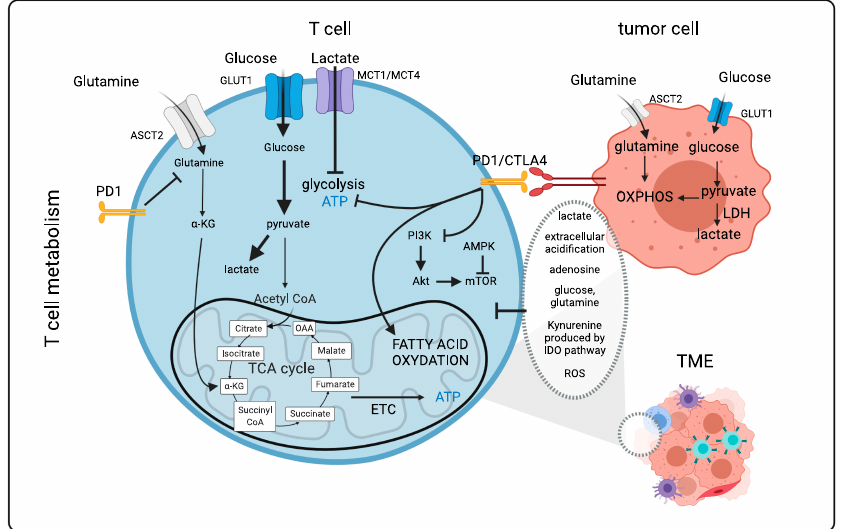
Figure 1 . T cell metabolism in the tumor microenvironment . Naïve T cells rely mainly on oxidative metabolism. Following activation with an antigen, T cells switch to a glycolytic metabolism by activation of the mTOR pathway. This metabolic program supports effector T cell functions. If antigen stimulation persists long term, such as in the tumor environment, inhibitory receptors such as PD1 and CTLA4 can rewire T cell metabolism by reducing glycolysis and glutaminolysis, which weakens effector functions. Other factors in the TME contributing to the exhausted state of T cells include low levels of oxygen, low levels of tryptophan metabolized into kynurenine by IDO, low levels of arginine, high levels of lactate and resulting acidification and strong competition of T cells with cancer cells for glucose and glutamine. PD1: Programmed cell death 1; CTLA4: cytotoxic T-lymphocyte-associated protein 4; ASCT2: ASC amino-acid transporter 2; GLUT1: glucose transporter 1; OAA: Oxaloacetate;